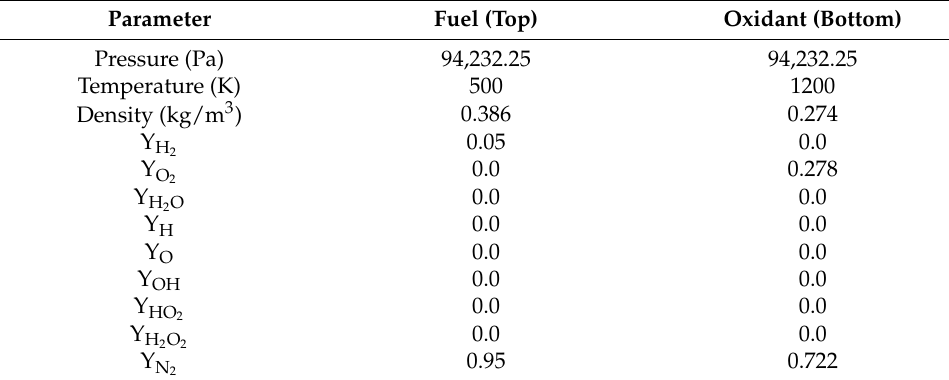
Table 2. Initialization parameters of the reaction